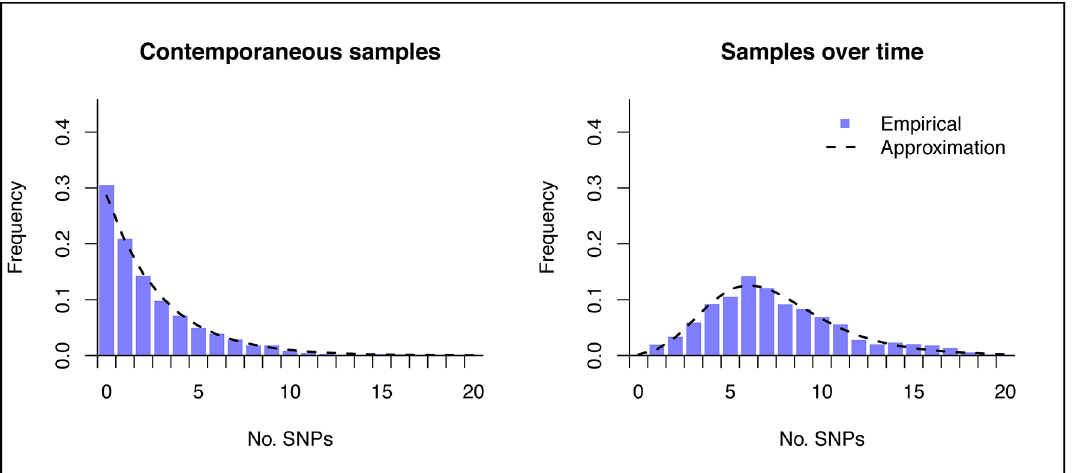
Fig 5. Theoretical and empirical distribution of the genetic distance between sampled isolates. The plots show the genetic distance distribution between two isolates sampled from a simulated population at time 20000 (left) and between isolates sampled at times 10000 and 20000. Empirical distributions were calculated from twenty simulated populations, and 500 sampled isolates at each sampling time, under population size 2500 and mutation rate